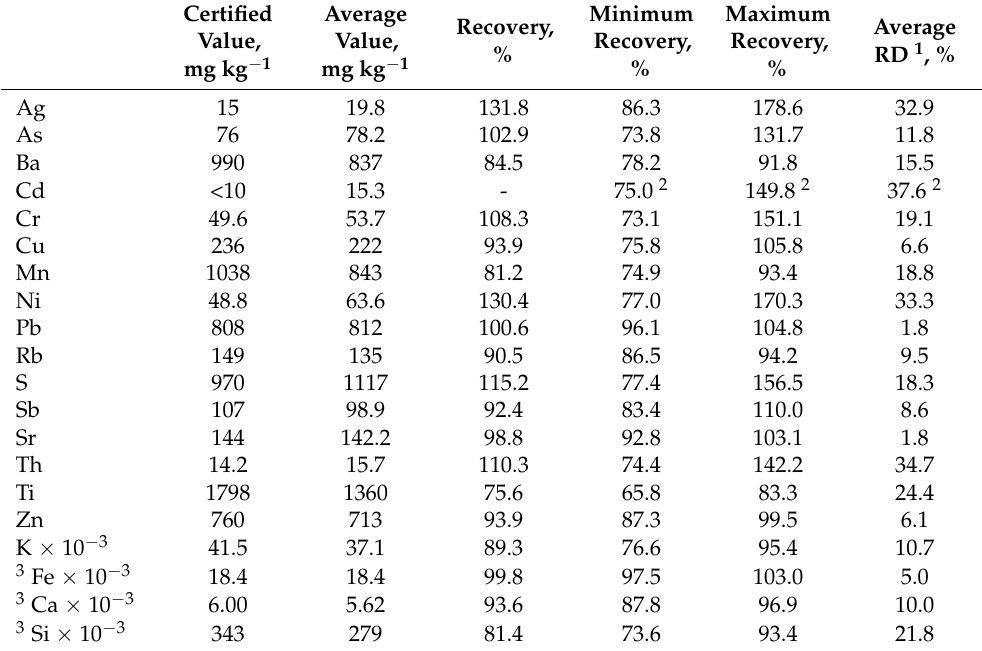
Table 3. Performance of the instrument: variations in daily measurements (N = 21) of the certified reference material sediment